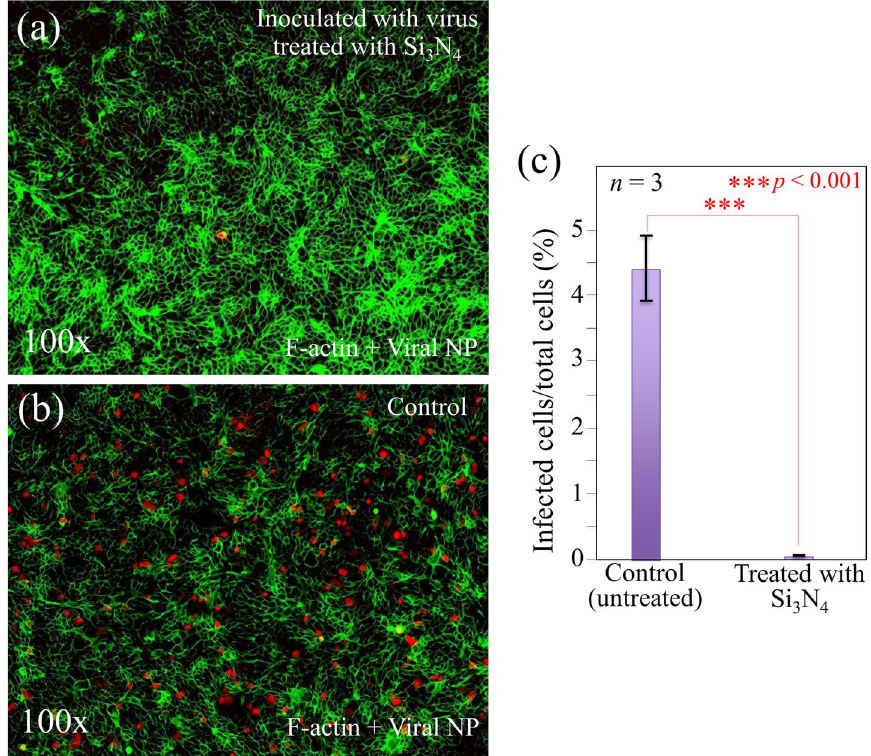
Figure 7. Fluorescence micrographs of the MDCK cell population inoculated with Influenza A H1N1 virions (green cell F-actin; red viral nucleoproteins): ( a ) cells inoculated with virions that were preliminarily exposed for 5 min to 15 wt.% Si 3 N 4 -containing aqueous solution; and, ( b ) cells inoculated with virus exposed for 5 min to pure aqueous solution (control sample). In ( c ), quantification with related statistical validation of infected cells is obtained upon direct counting on fluorescence micrographs. The full set of fluorescence micrographs for both samples is shown in Figs. S-4 and S-5 of the Supplementary Information.